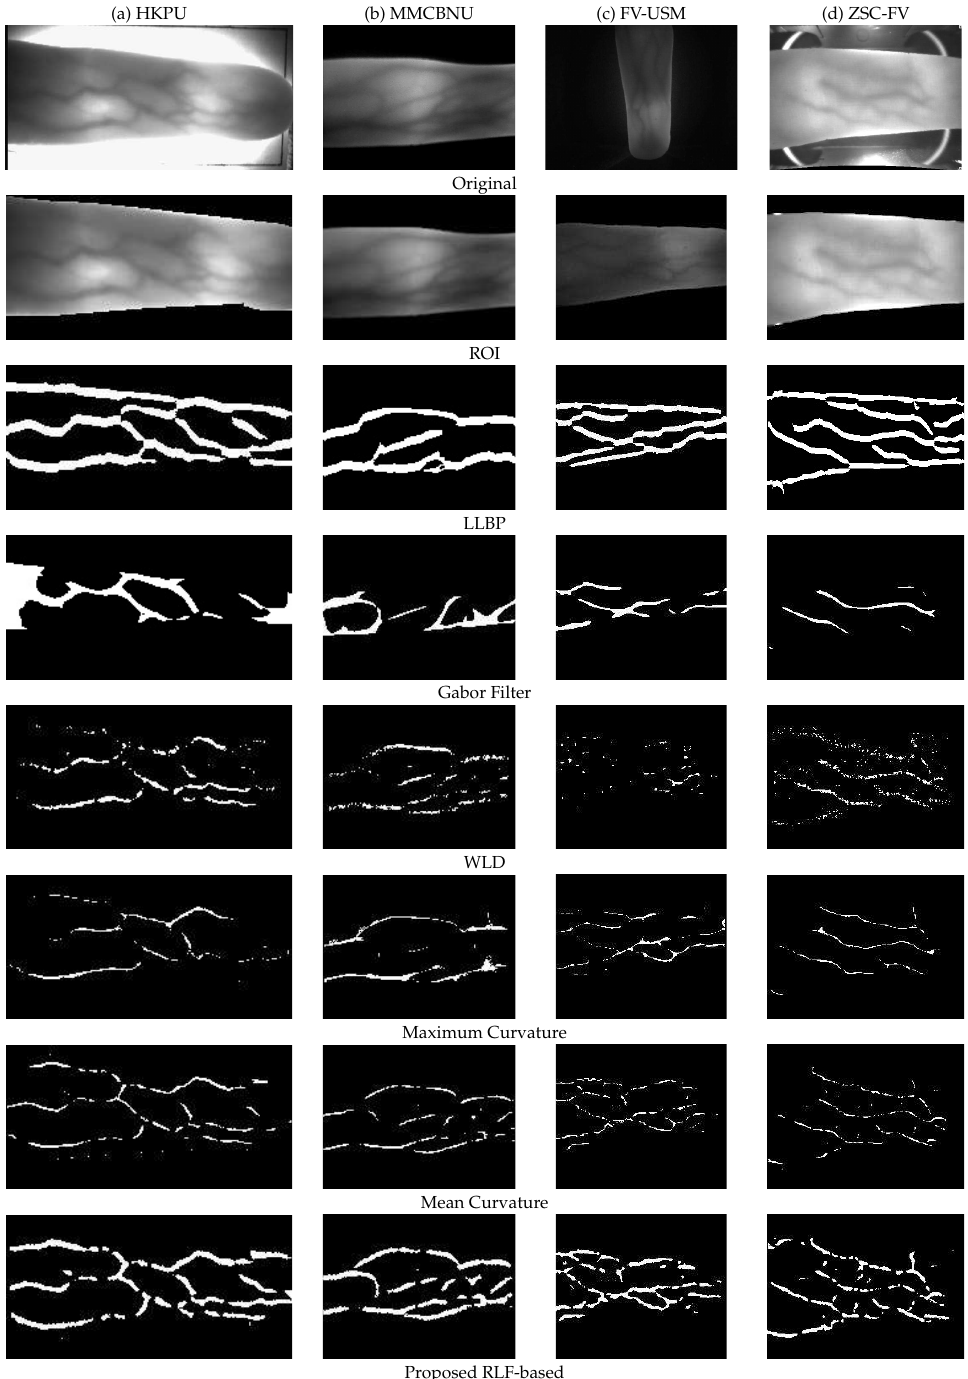
Figure 12. Different finger vein feature extraction methods are carried out on four image samples from different databases. The first and second rows show the originally acquired images and their corresponding ROI images. Here, we uniformly adopted the strategy in [62] to obtain ROI. The third to eighth rows show the extracted feature images by using LLBP, Gabor Filter, WLD, Maximum Curvature, Mean Curvature, and our proposed RLF-based method,